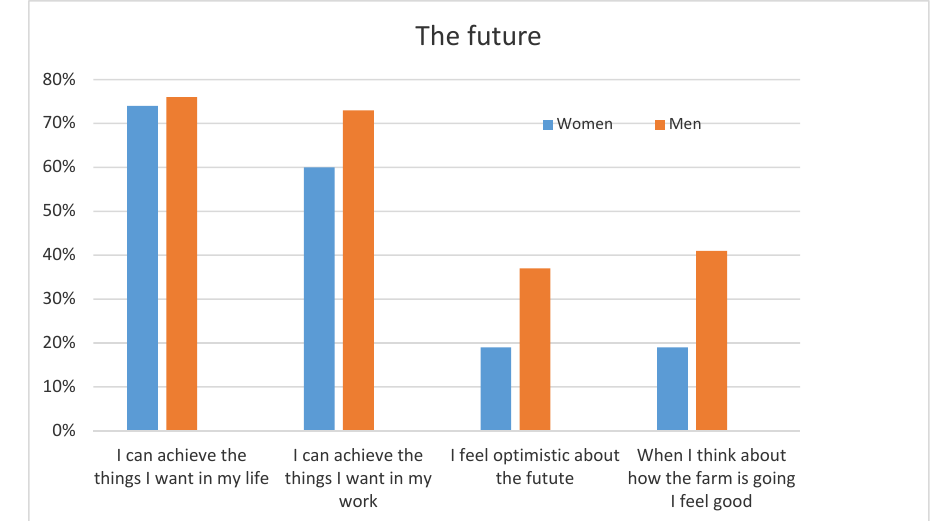
Figure 4. Achievement and optimism.